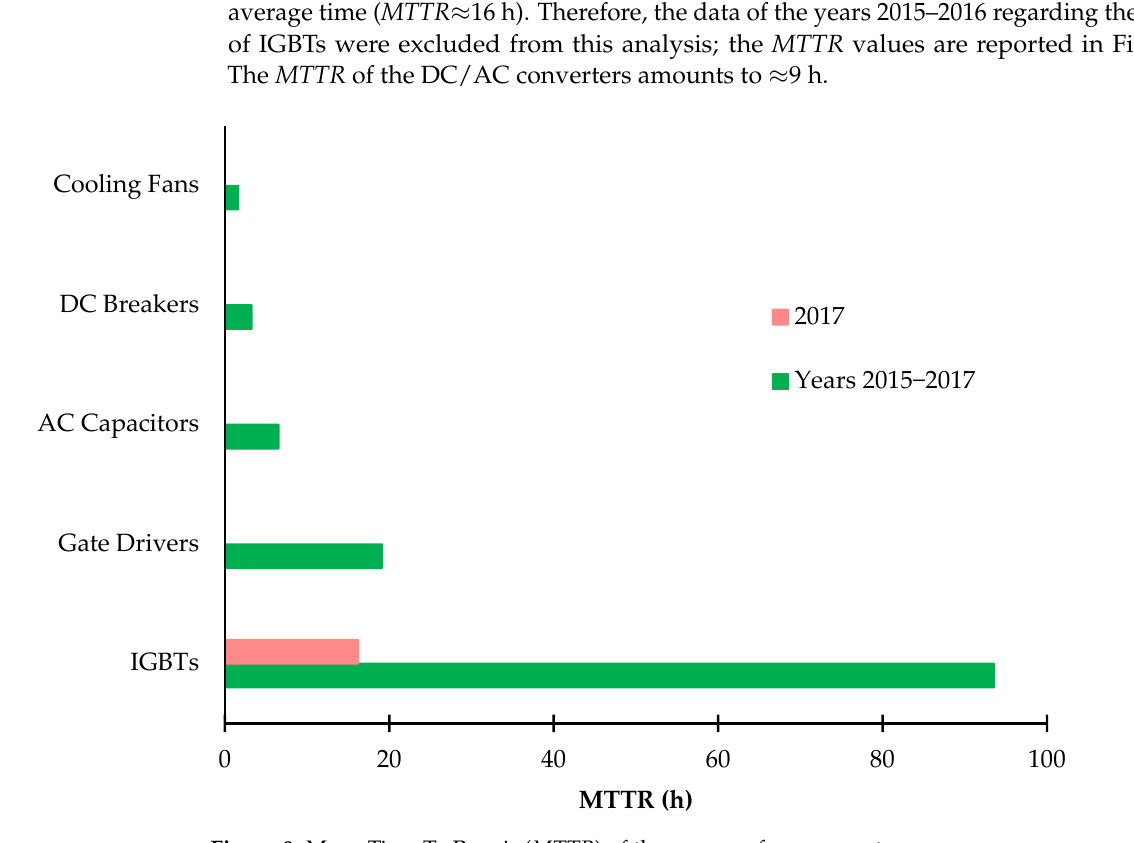
Figure 8. Mean Time To Repair ( MTTR ) of the groups of components.